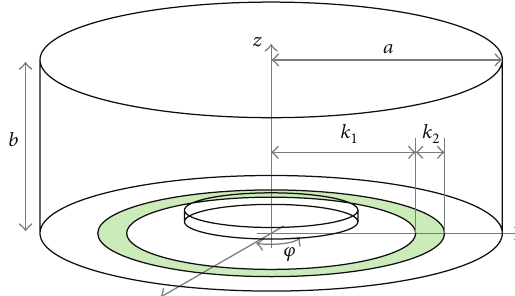
Figure 5: Geometrical representation of the PDE model. Taking advantage of the axial symmetry of the chip, the entire system is represented as a two-dimensional rectangular region. Similarly the heater is represented as a line instead of being a surface. This reduction of one dimension allows the model to be solved for the temperature in a three-dimensional space but at a small fraction of the time and computational resources required by a FEM